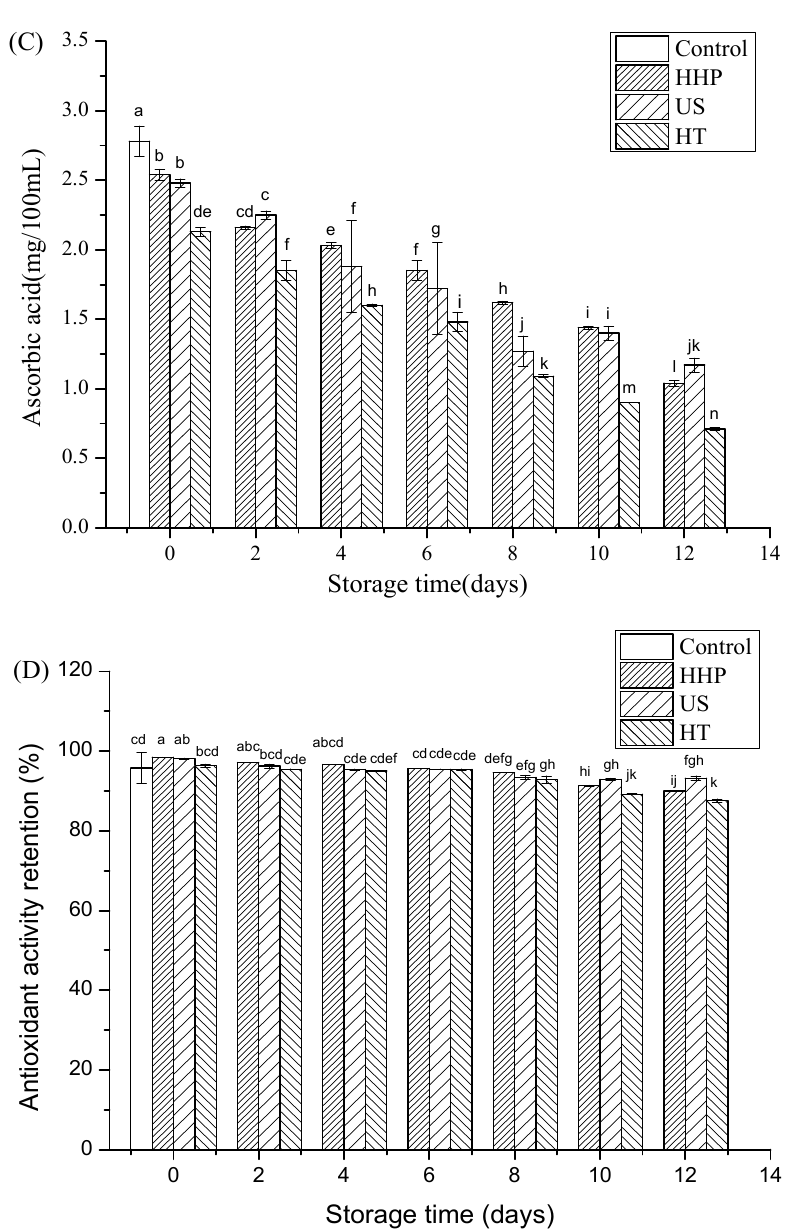
Figure 2. Changes in the total phenols ( A ), total anthocyanin ( B ), ascorbic acid ( C ), and antioxidant activity ( D ) in juice blends treated by HHP, US, and HT after 12 days of storage at 4 °C. HHP: high hydrostatic pressure (500 MPa/15 min/15 °C), US: ultrasound (376 W/10 min/35 °C), HT: heat treatment (86 °C/1 min). Each column represents a mean and the vertical bars indicate the standard deviation. Means with different letters within the same color columns are significantly different (Duncan test, p < 0.05).